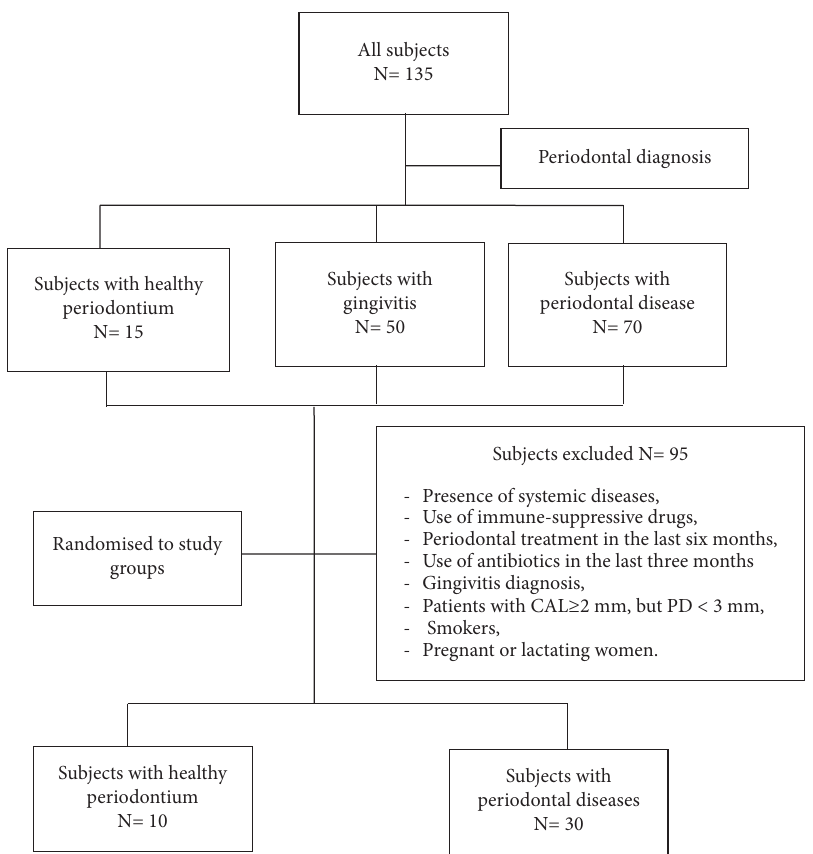
Figure. 1: Flowchart of the progress of subjects through the phases of the